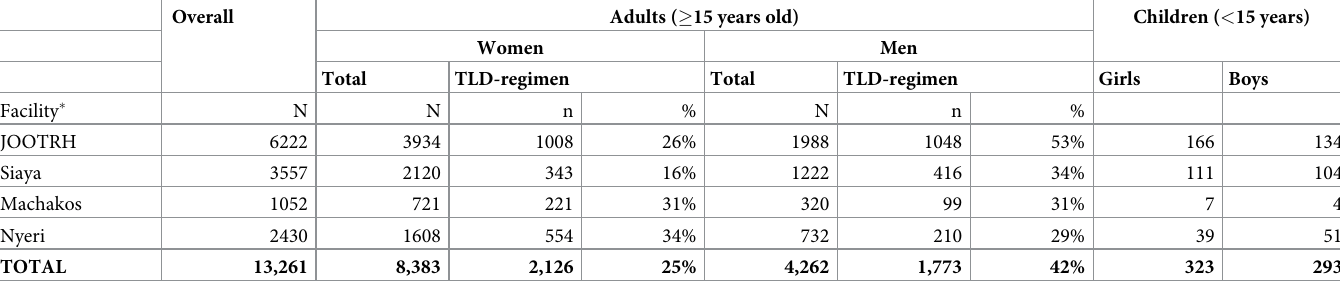
Jaramogi Oginga Odinga Teaching and Referral Hospital (JOOTRH), Siaya County Referral Hospital, Machakos Level 5 Hospital and Nyeri County Referral Hospital; TLD: tenofovir+lamivudine+dolutegravir